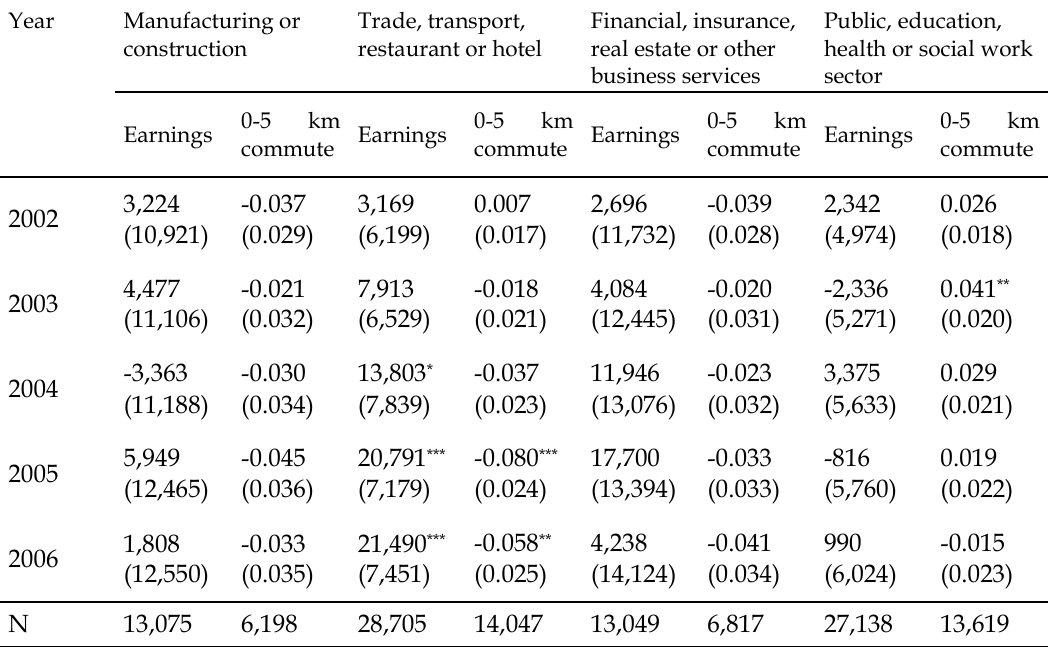
Table 6. Estimated post-treatment effect of improved job accessibility by employment